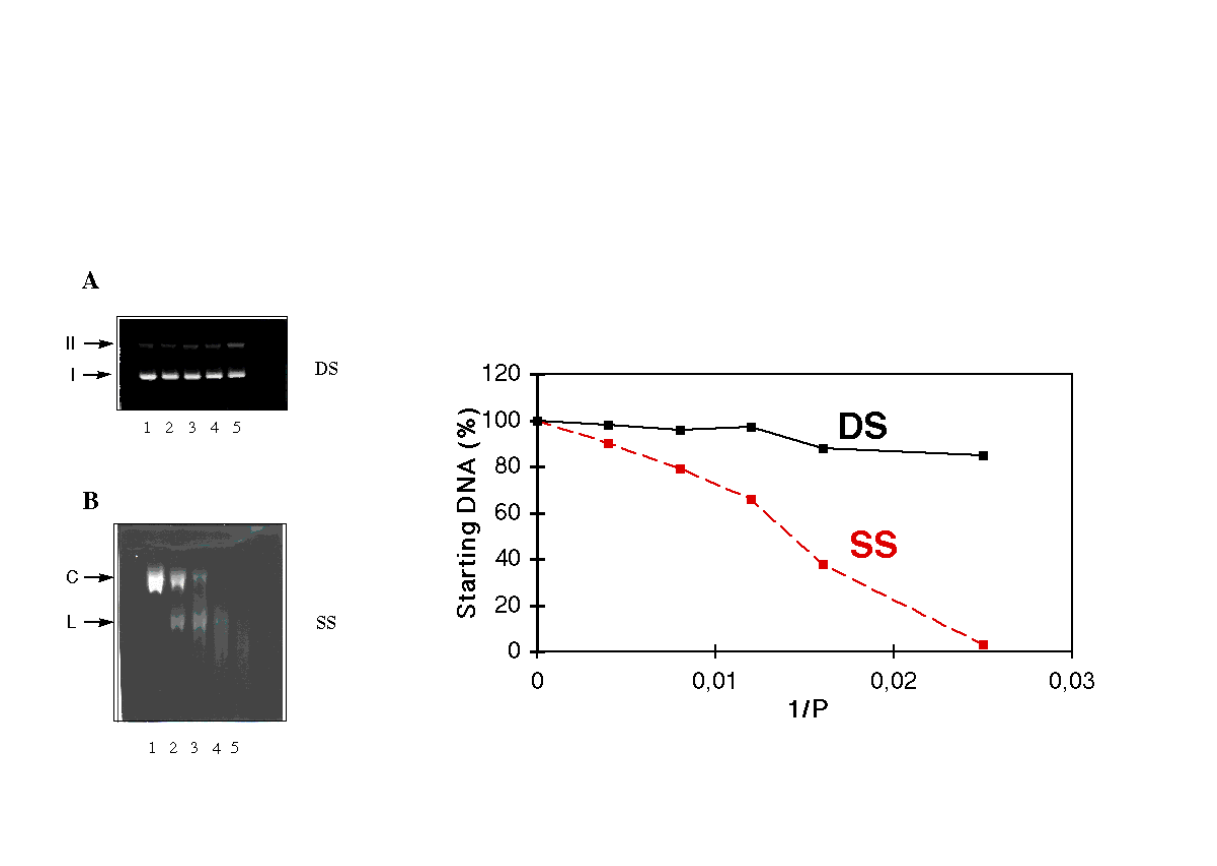
Figure 9. (Left, A,B): agarose gel electrophoresis patterns for the separate photocleavage of ds pUC18 DNA (A) and ss M13mp18 (B) by 1 ; [DNA]: 0.3mM in nucleotide phosphate unit; [ 1 ]/[Phosphate]: lane 1,0; lane 2, 1/250; lane 3, 1/125; lane 4, 1/160; lane 5, 1/130. (Right): photocleavage of mixtures of pUC18 and M13mp18 by 1 : [ds DNA] = 0.3mM in nucleotide phosphate unit; variation of ds and ss DNA as a function of the concentration of 1